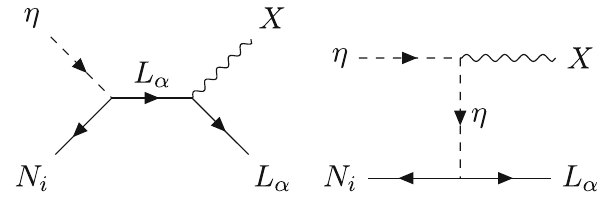
Fig. 1 Feynman diagrams contributing to (cid:10) σv (cid:11) DMDM → XL and the asymmetry (cid:13) at leading order. Here X ≡ γ, W ± ,